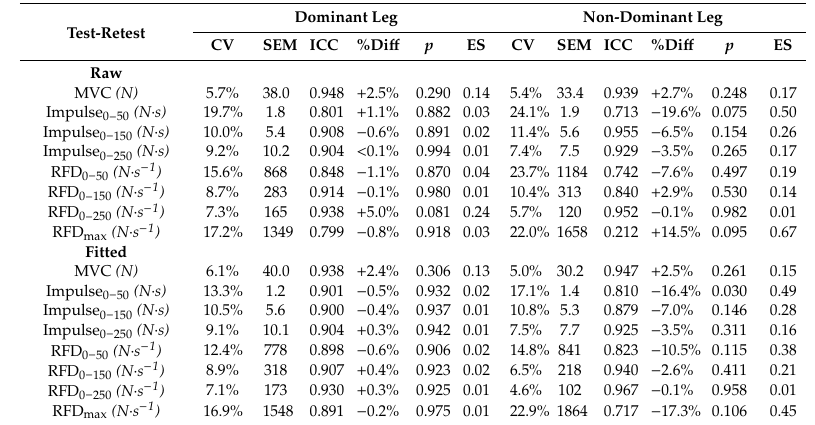
Table 3. Test-retest reliability (values of the highest trial conducted in Sessions 1 and 2) in maximal voluntary contraction force (MVC), rate of force development (RFD) and impulse variables for original (raw) and filtered (fitted) data.